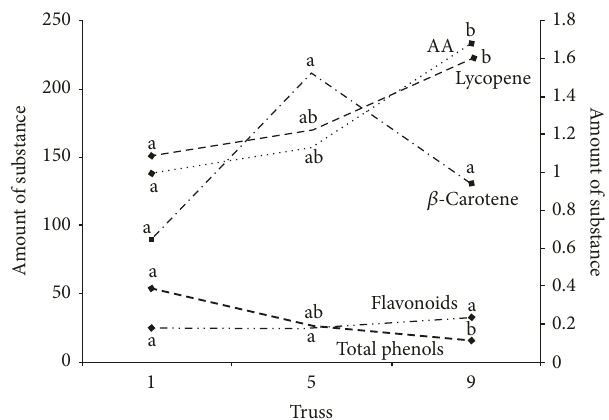
Figure 2: Behavior of bioactive compounds and antioxidant activity in three distinct trusses in the control group. Each point is the average of three replicates. Different letters between rows indicate significant differences at 𝑃 ≤ 0.05 . Units for lycopene: 100g mg −1 FW; 𝛽 -carotene: 100g mg −1 FW; total phenols: 𝜇 g GAE g −1 FW; flavonoids: RE g mg −1 FW; antioxidant activity: 𝜇 M TEAC 100g −1 FW.